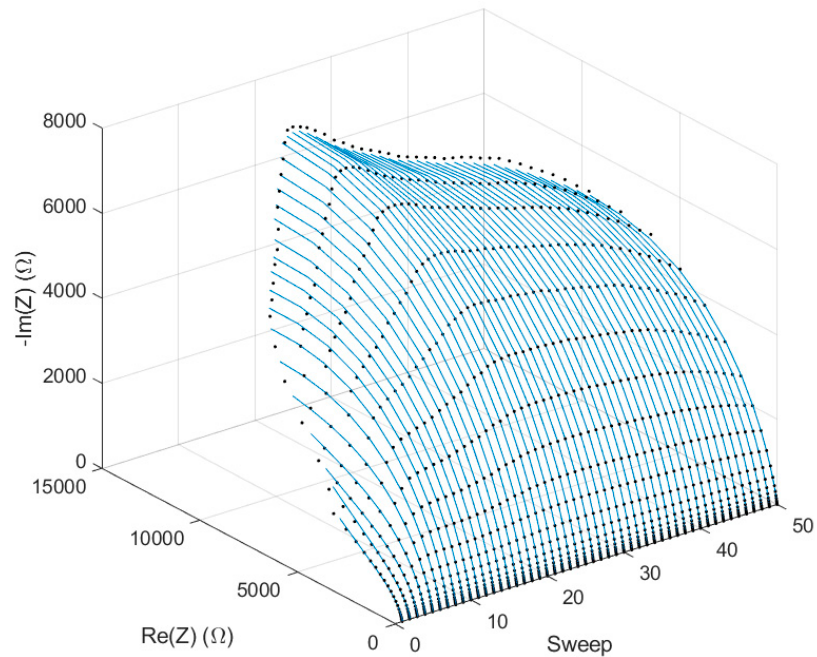
Figure 7. Nyquist diagram of electrochemical impedance spectroscopy (EIS) data (50 repeated measurements) in 10 mM PBS (black dots), and results of the fits with the electrical model of Figure 1c.